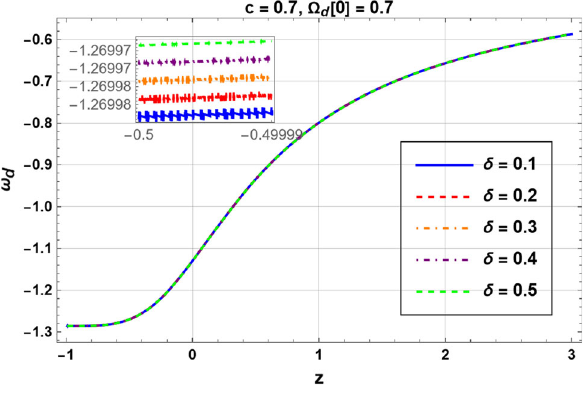
Fig. 4 The evolution of EoS parameter w d of NTHDE with c = 0 . 7 and δ = 0 . 1 to 0 . 5 is plotted w.r.t. redshift z by considering (cid:6) d [ z = 0 ] ≈ 0 . 7 , M 2 p = 1